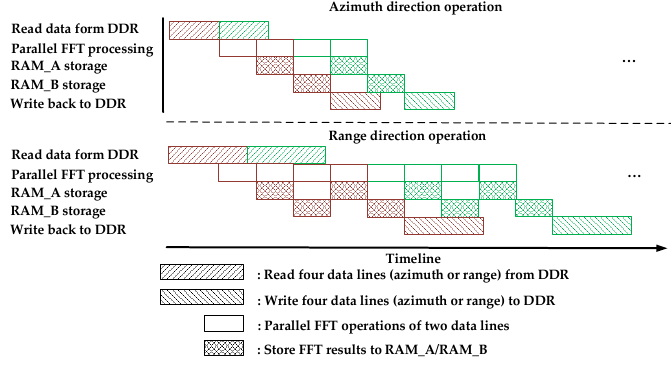
Figure 12. Parallel processing timeline of one round-robin assignment.